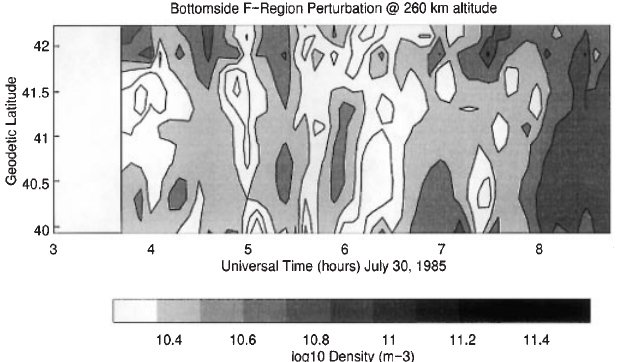
Fig. 3. Radar elevation scan data in the bottomside F layer show the initial latitude spread of the hole to cover (cid:24) 2 (cid:176) of latitude and the subsequent oscillation of the density across the field-of-view of the experiment with (cid:24) 40-min period. Iso-density contours at fixed altitude (260 km) are